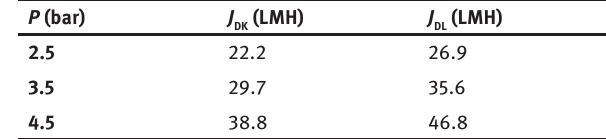
Figure 3: Particle size distribution in compost leachate (a) and after jar test (b). Table 2: Millipore water